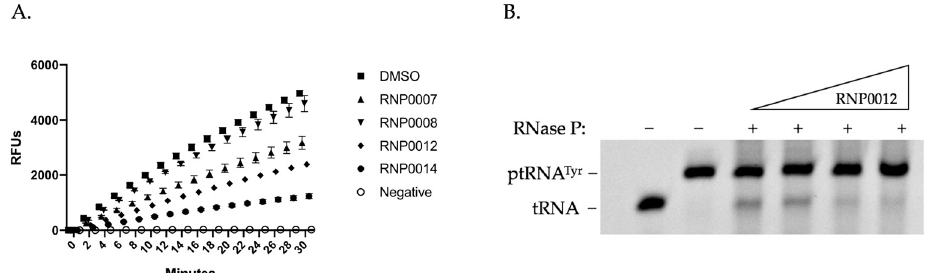
Figure 2. Representative RNP analog inhibition of in vitro RnpA-mediated RNA degradation ( A ) or ptRNA Tyr processing ( B ). Panel A. DMSO ( ◼ ) or 50 µM of compound was incubated with RnpA in the presence of the FRET RNA substrate for 30 min at 37 °C. Fluorescence measurements (RFUs) were collected every 2 min at excitation 490 nm, emission 520 nm. The negative control ( ○ ) with no protein ensures the absence of contaminating nucleases. Panel B. 0, 50, 250, or 500 µM RNP0012 was incubated with 10 pmol RNase P and ptRNA Tyr for 30 min at 37 °C and conversion of ptRNA to tRNA was evaluated by urea-PAGE; migration of tRNA Tyr and ptRNA Tyr are shown.